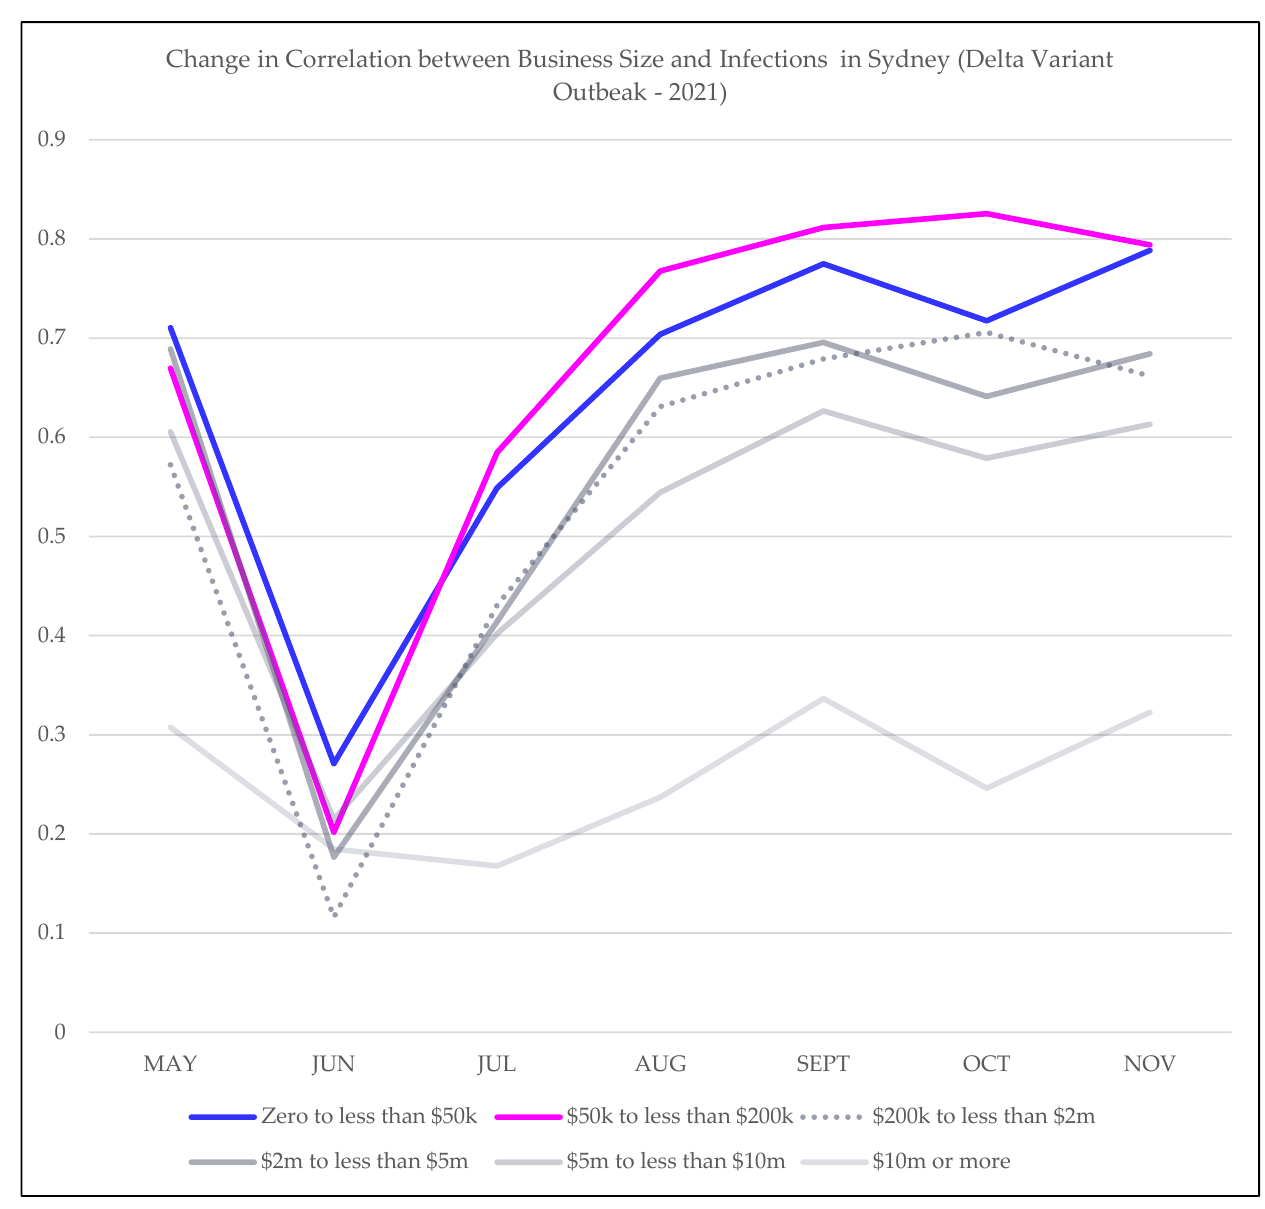
Figure 8. The changing risk profile of construction businesses over the duration of the outbreak of the Delta Variant in Sydney.